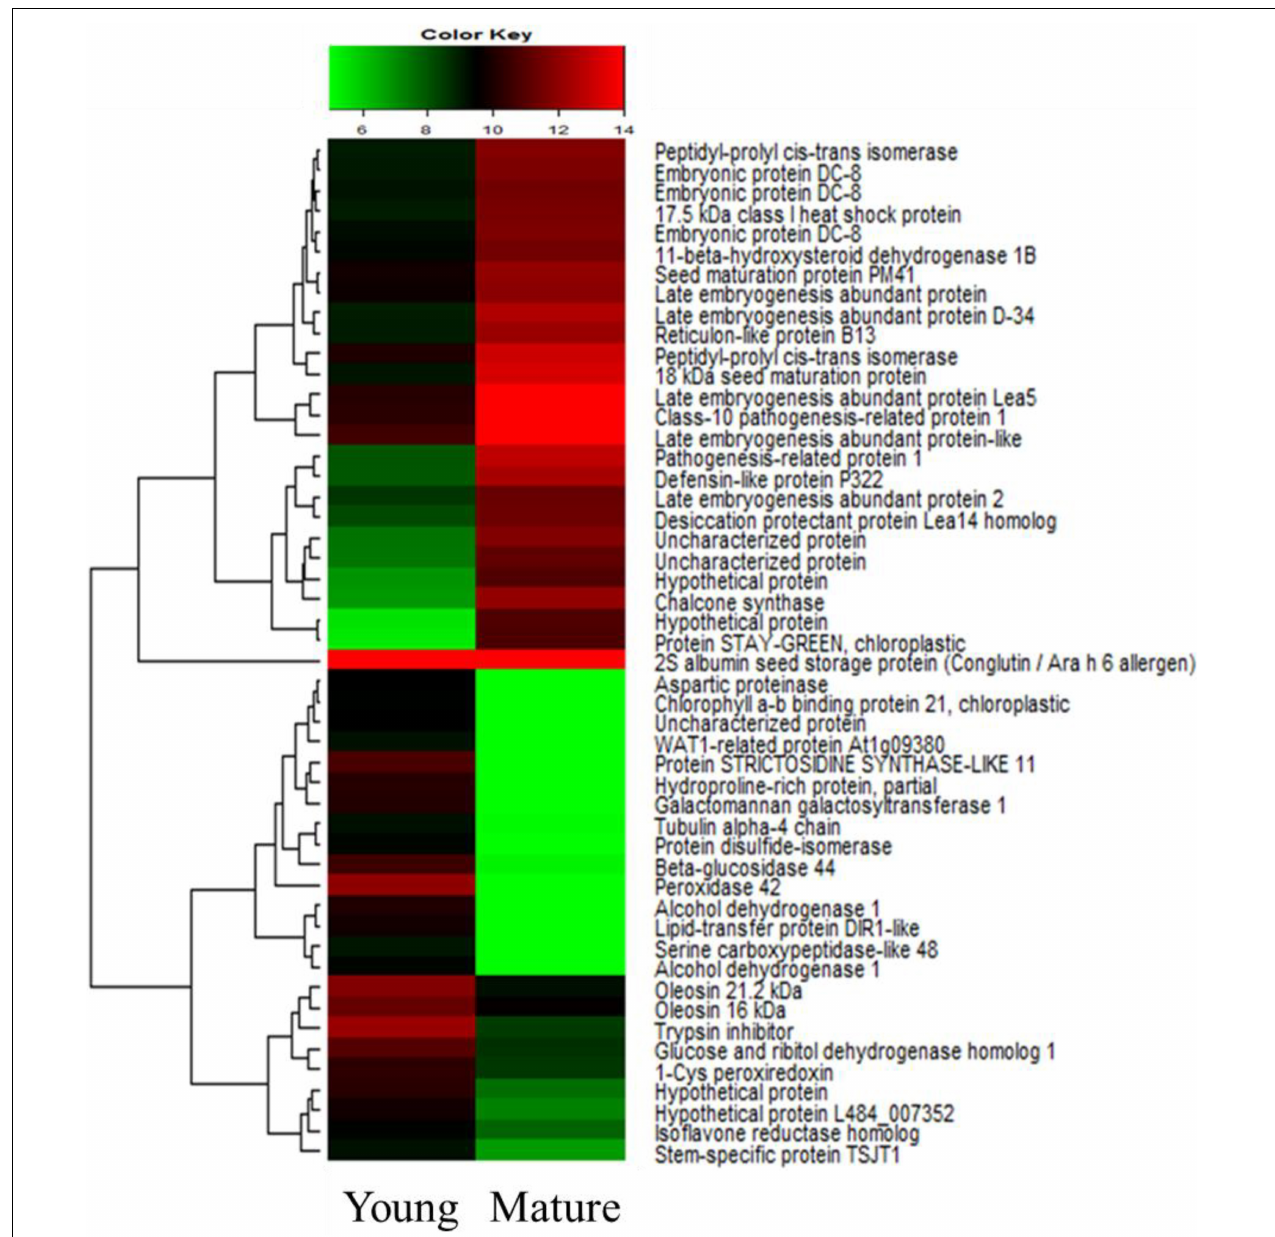
FIGURE 2 | Heatmap of the top 25 up-regulated and 25 down-regulated genes according to the seed development stage of Senna occidentalis. The color bar indicates the value of the expression level in a sample.